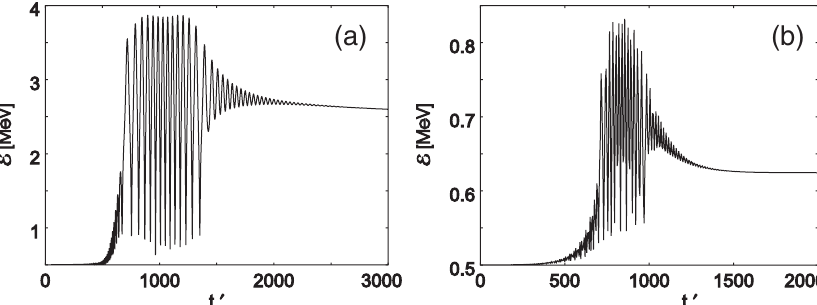
FIG. 1. Reflection capture of a particle initially in rest (at the longitudinal position x 0 ¼ 0 ; transversal coordinates y; z are cyclic for plane waves, so y 0 ¼ z 0 ¼ 0 ) from a plane counterpropagating laser pulses of finite duration (a) for ! 1 =! 2 ¼ 10 , and (b) ! 1 =! 2 ¼ 2 . The laser intensities have above critical peak values (cid:2) 10 ¼ (cid:2) 20 ¼ 2 for (a), and (cid:2) 10 ¼ (cid:2) 20 ¼ 0 : 5 for